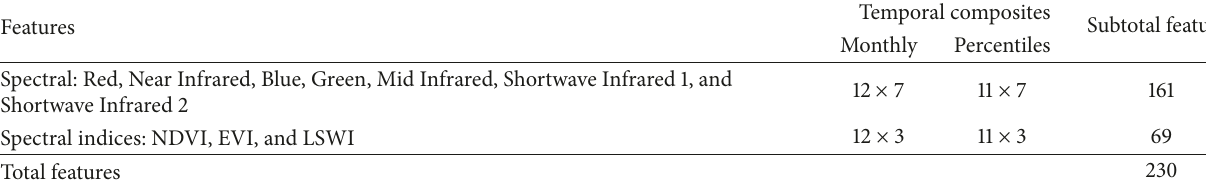
Table 2: Description of the input features used in the research.